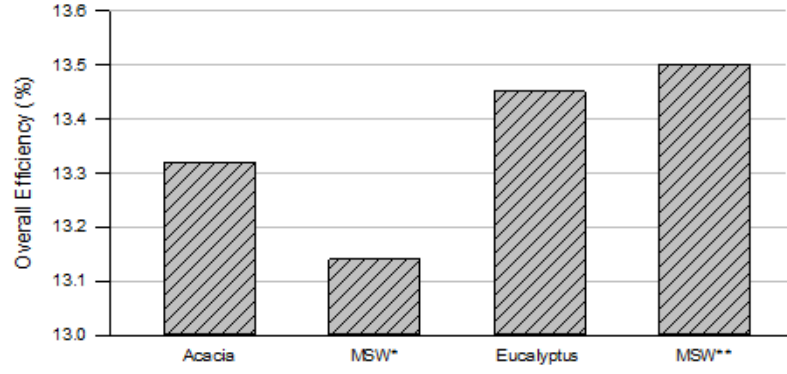
Figure 5. Overall e ffi ciency for the four fuels Figure 5. Overall efficiency for the four fuels considered.